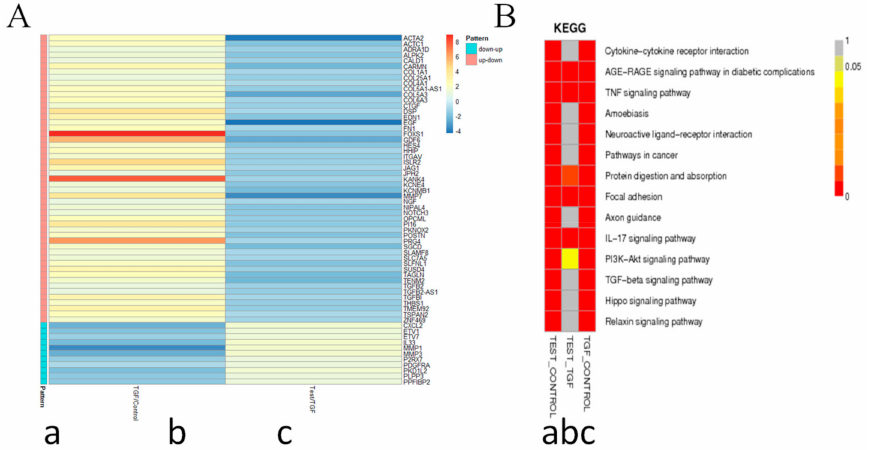
Figure 6. Transcriptome sequencing of LX-2 cell samples. The total mRNAs of LX2 cells were extracted, and the transcriptome sequencing were analyzed in three conditions: a) normal, b) TGF β 1 treatment and c) TGF β 1 and 8a co-treatment after 24 h. Significantly di ff erentially expressed genes were identified when three groups were compared with p < 0.05 and | Log2FoldChange | > 1. A). Expression of profiling and heatmap of the above-mentioned grouping of 60 genes. B) Prediction of the Kyoto Encyclopedia of Genes and Genomes (KEGG) pathway analysis in each of two groups.